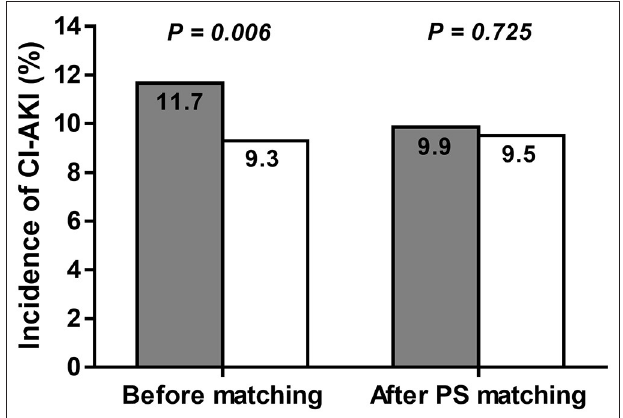
FIGURE 2 | Incidence of contrast-induced acute kidney injury (CI-AKI) before and after propensity score (PS) matching in low-osmolar contrast media (LOCM) users (gray column) and iso-osmolar contrast media (IOCM) users (white column). The incidence of CI-AKI was not significantly different between the LOCM users and IOCM users after PS matching (9.9% vs. 9.5%; p =